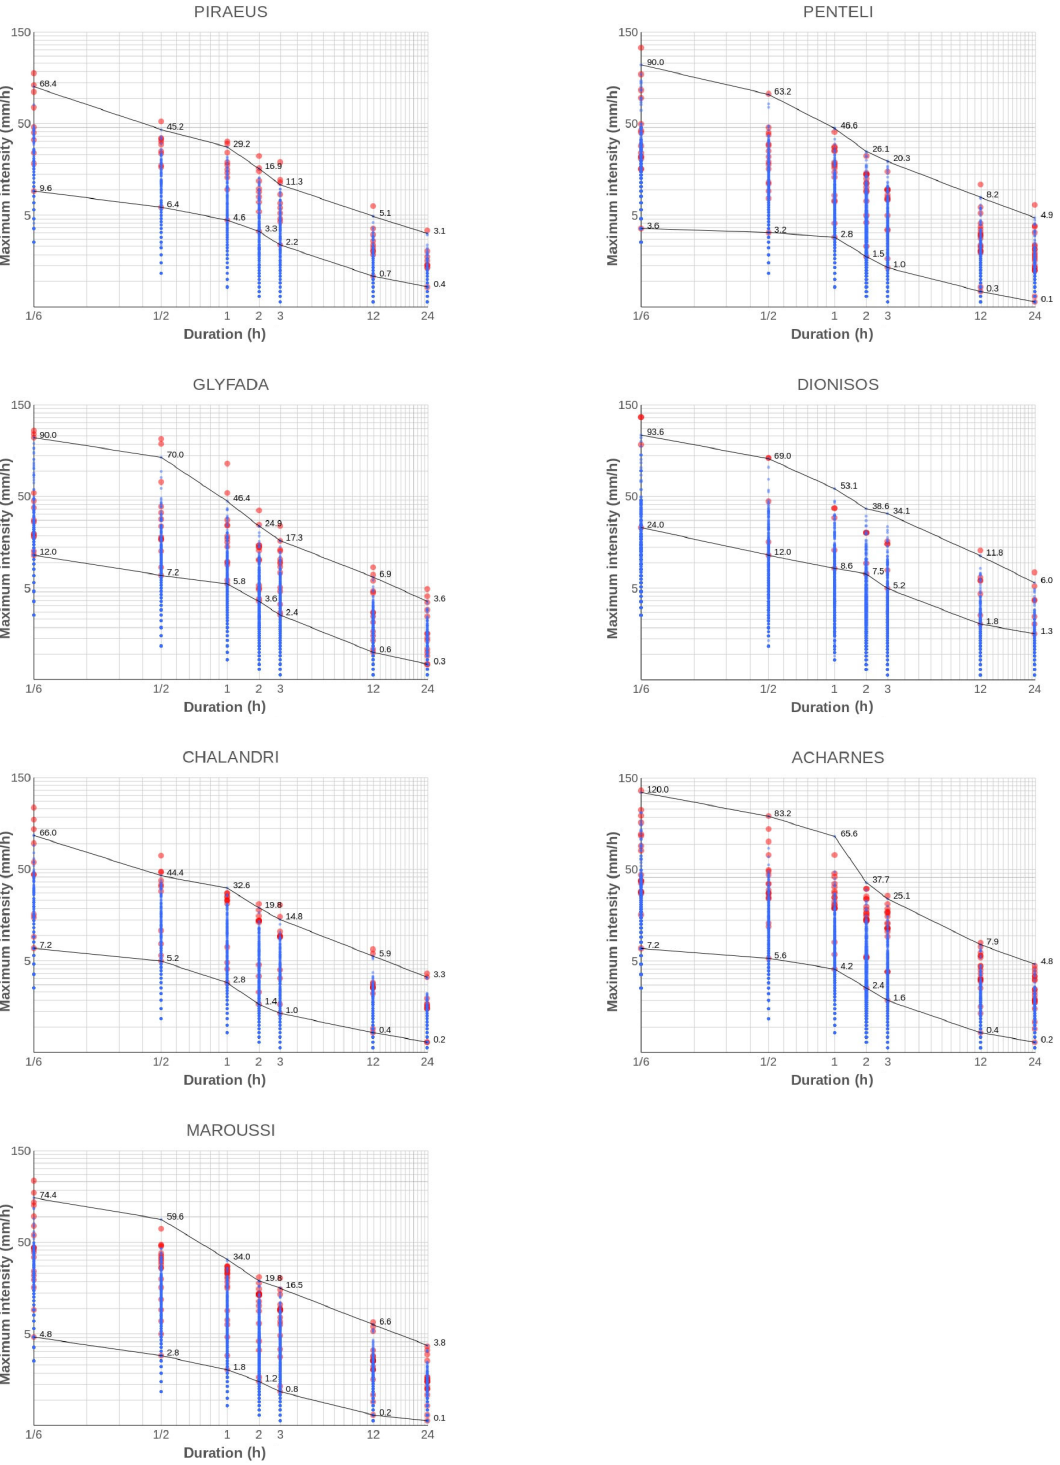
Figure 7. Peak rainfall intensities versus duration graphs, at each sub-area shown in Fig. 2. Peak intensities for each sub-area derive from the rainfall data recorded by all the representative rain gauges shown in Fig. 2. Red dots represent the events that led to reported flooding. All graphs use logarithmic x axis